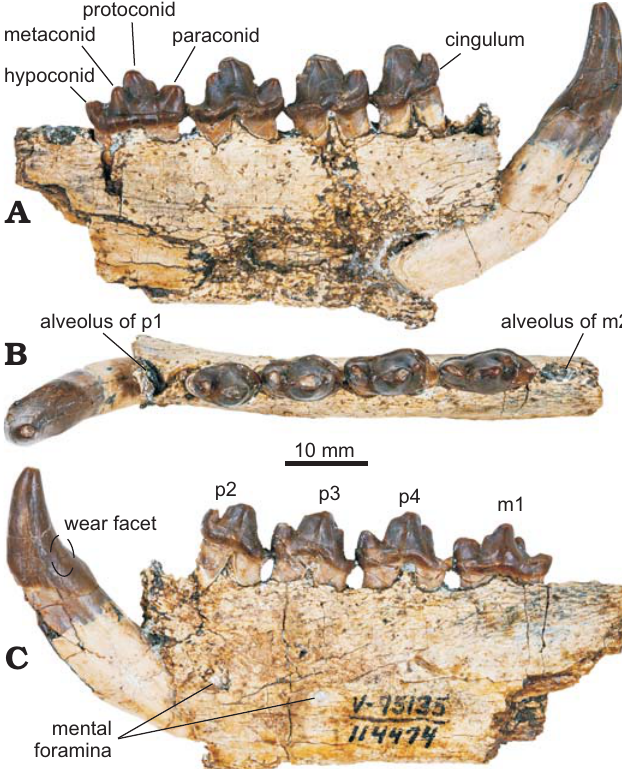
Fig. 3. Mandible of pinniped mammal Enaliarctos mealsi (UCMP 114474) from Schooner Gulch, Mendocino County, California, earliest Miocene; in lingual ( A ), occlusal ( B ), and labial ( C ) views.